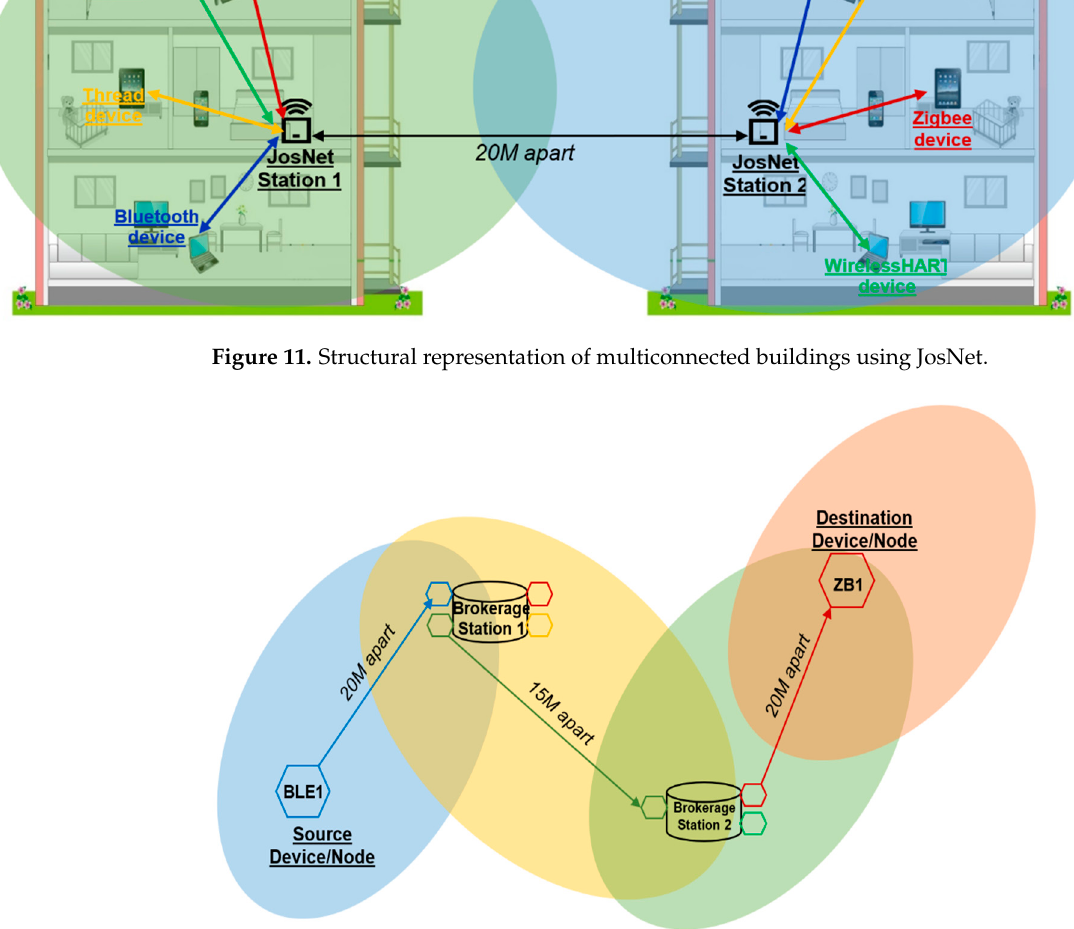
Figure 13. A JosNet Station Capable of Accommodating Multiple Network Technologies within a Single Station 4. Results and Evaluation In this section, we present and discuss the range of experimental setups and results from the integration of wireless network protocols across different connection set ‐ ups to evaluate the performance of our brokerage. The following key will be used throughout this section: End ‐ to ‐ end latency = time interval between departure time of first bit from source when the first bit leaves source to arrival time destination; Date Loss = difference between sent file size and received file size; Data Size = size of the data packet sent across the network from source to destination node; Average Time = (T 1 + T 2 + … + T n )/n, where T represents time. 4.1. Experimental Setup Achieving the best results involved running the experiments multiple times (in this case, over 10 times) for every separate setup and connection pair, at different times of the